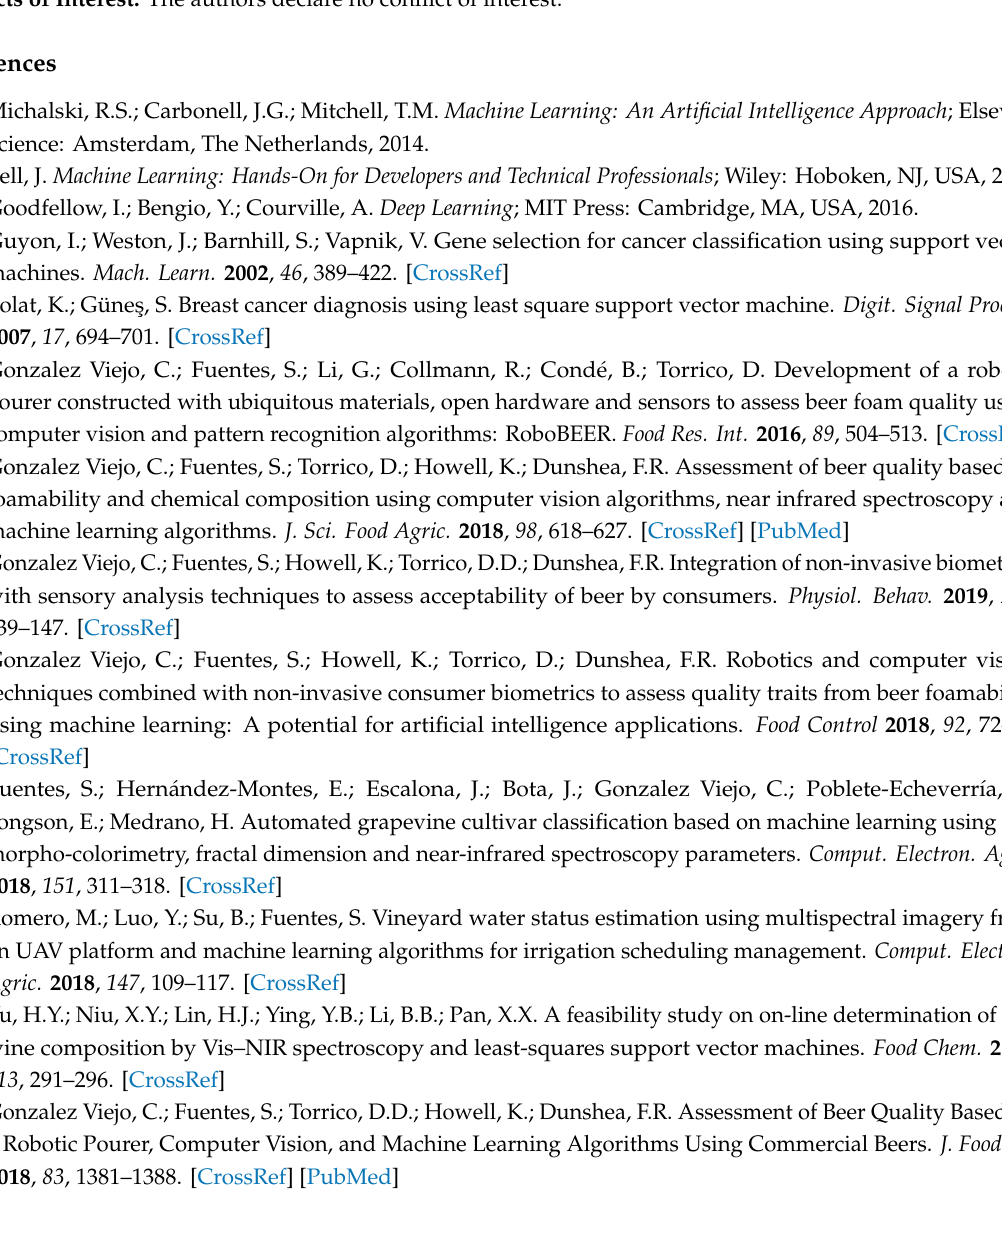
Table S1: Statistical results of the models developed using the backpropagation with Jacobian derivatives algorithm. Numbers in green and bold represent the models with the highest correlation and determination coe ffi cients. TableS2: Statisticalresultsofthemodelsdevelopedusingthebackpropagationwithgradientderivative algorithms. Numbers in red and italics represent the models with the lowest correlation and determination coe ffi cients, while those in green and bold represent the highest values. Table S3: Statistical results of the models developed using the supervised weight and bias algorithms. Numbers in red and italics represent the models with the lowest correlation and determination coe ffi